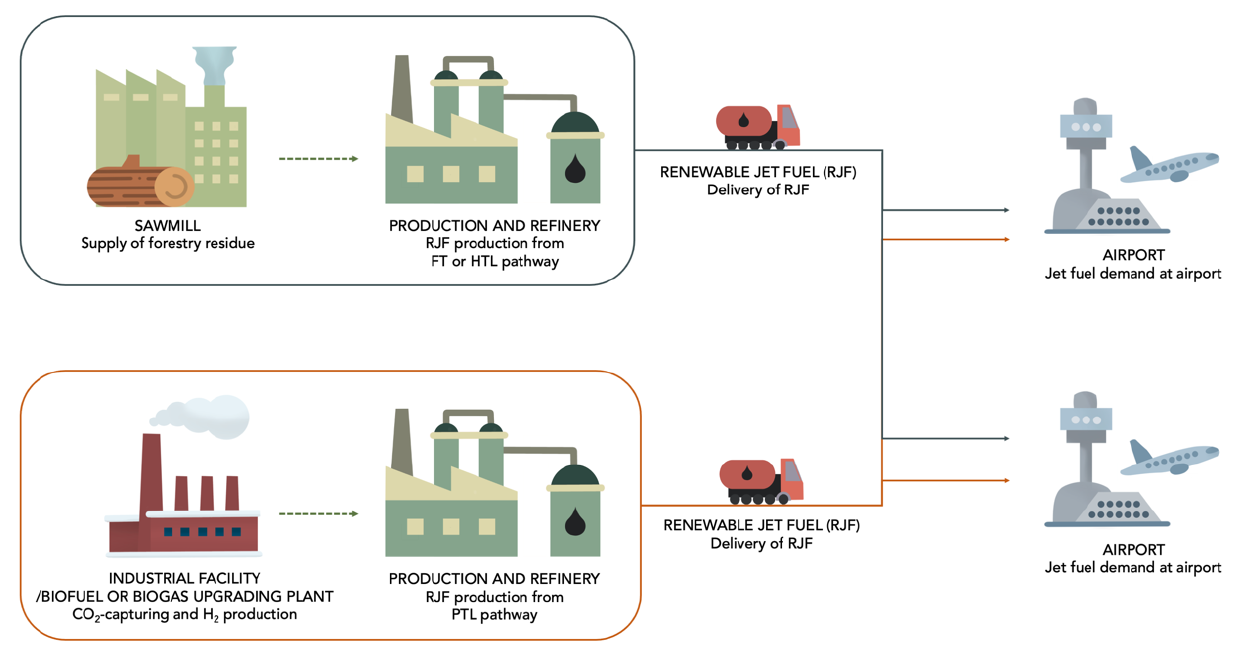
Figure 2. Visualization of developed supply chain model. FT (Fischer – Tropsch); HTL (Hydrothermal liquefaction); PTL (Power to liquid). Graphic content illustrated with inspiration from [76 – 80].